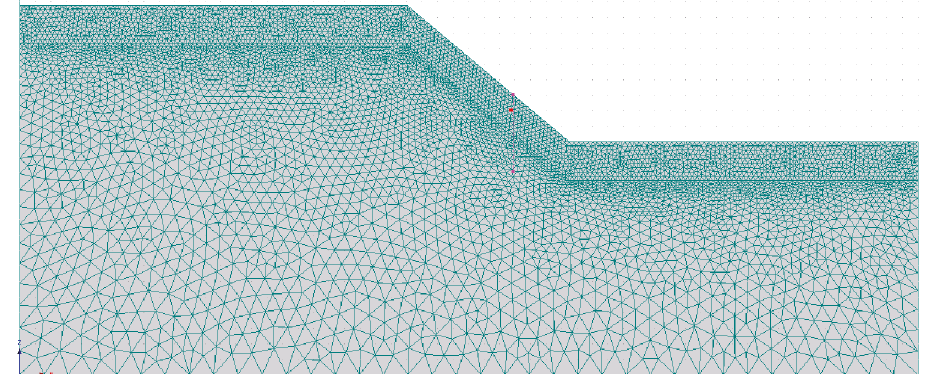
Figure 3: Illustration of the slope model